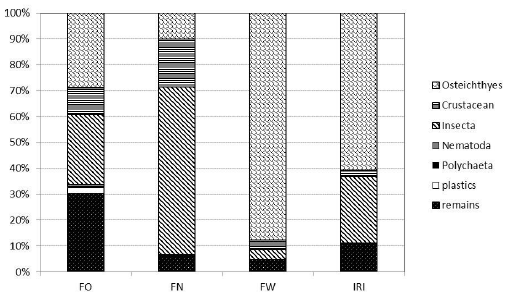
Figure 3. Food items of juvenile Elops saurus in Delta do Rio Parnaíba (PI) between July 2016 and April 2017. Frequency of occurrence (FO), Frequency numerical (FN), Frequency Gravimetric (FW) e Relative Importance Index